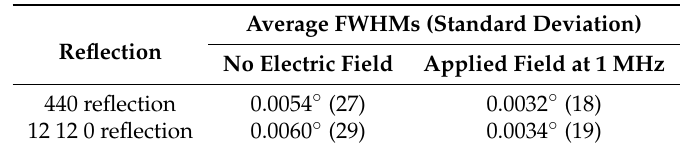
Table 1. Comparison of the average FWHMs measured for the 440 and 12 12 0 reflections from tetragonal HEW lysozyme crystals prepared with and without an external electric field. Standard deviations are given in parentheses. The average FWHMs are the deconvoluted values from the measured FWHMs. The number of FWHMs analyzed for crystals grown with and without an electric field at 1 MHz were 80 and 112, respectively.